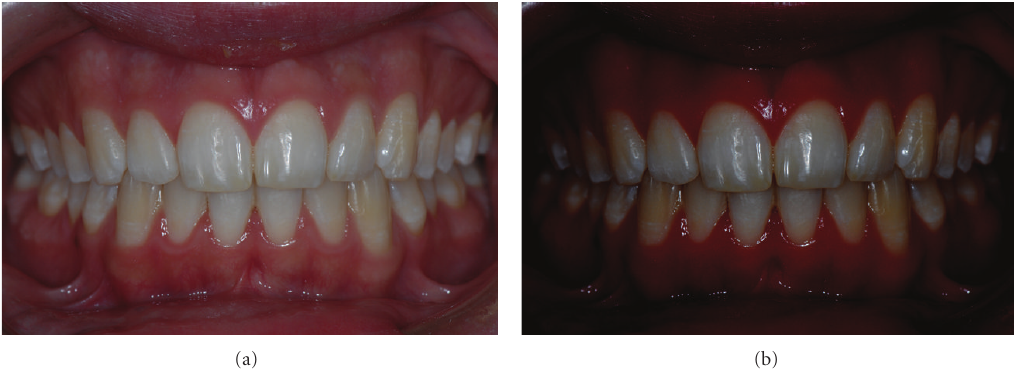
Figure 4: (a) Final frontal picture. (b) Software-modified final frontal picture.